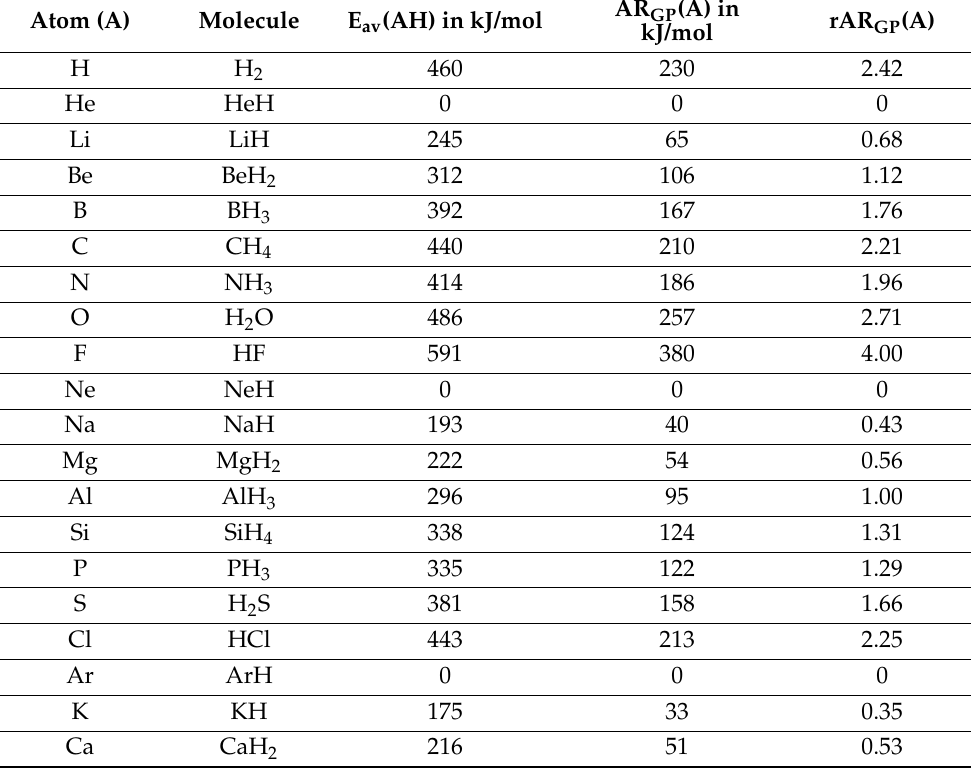
Table 2. Average bond energies (E b (AH)) and geometric Pauling-like atomic reactivities AR GP in kJ/mol together with corresponding relative reactivities rAR GP are shown for the atoms H through Ca.